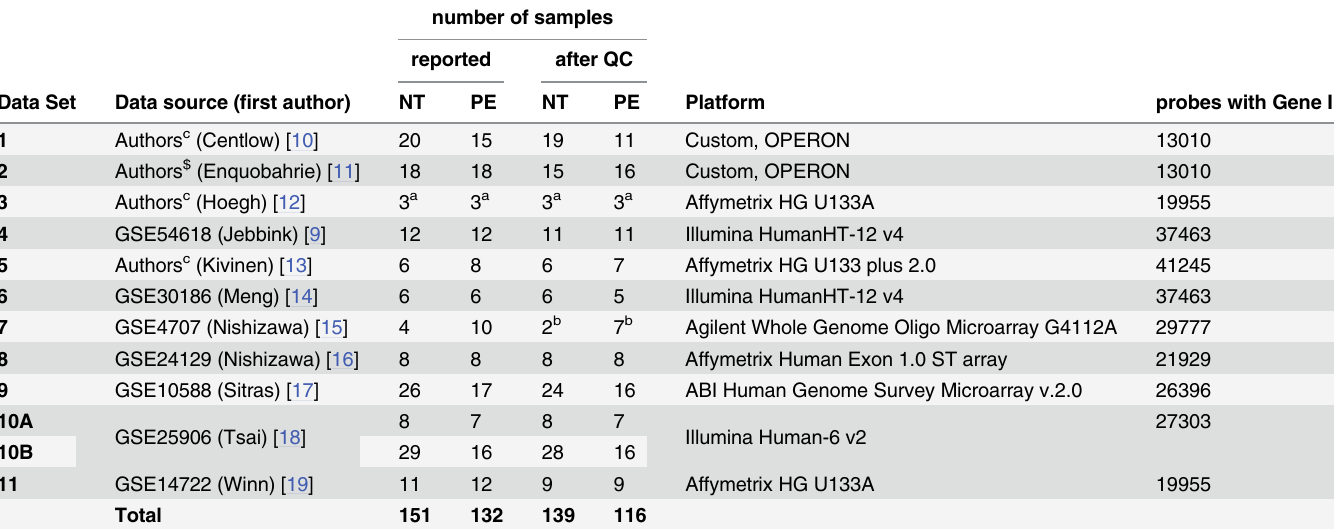
Table 1. Datasets included in the